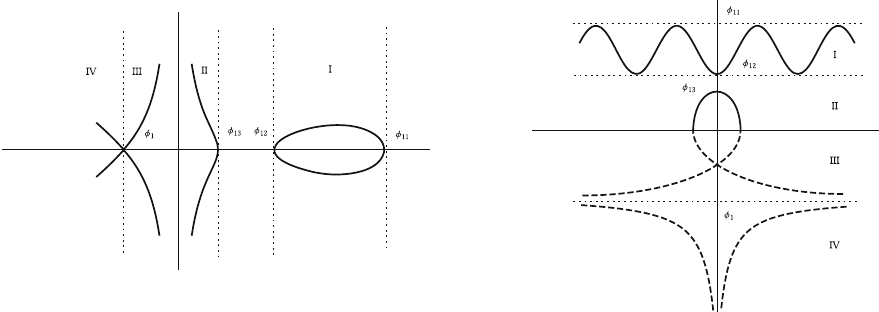
, three positive 1